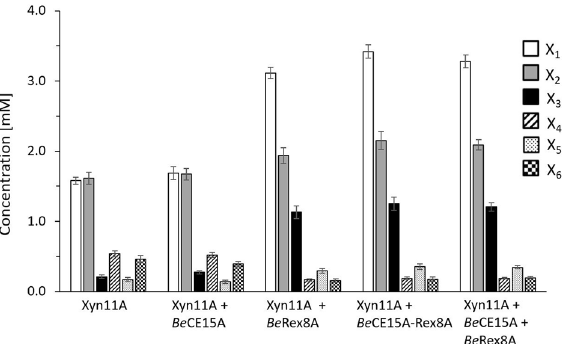
Figure 6. Xylooligosaccharide production profiles from corn cob biomass hydrolysis. The endo - β -1,4-xylanase Xyn11A from Neocallimastix patriciarum was either incubated alone or supplemented with Be CE15A, Be Rex8A, Be CE15A-Rex8A or an equimolar mix of Be CE15A and Be Rex8A. Reactions in which Be CE15A, Be Rex8A, and Be CE15A-Rex8A were incubated without Xyn11A yielded no detected sugars (data not shown), as expected of a Rex enzyme and a GE. Presented are xylose (X 1 , white), xylobiose (X 2 , gray), xylotriose (X 3 , black), xylotetraose (X 4 , striped), xylopentaose (X 5 , dotted), and xylohexaose (X 6 , checkered) concentrations after 30 h of incubation that were determined using high-performance anion-exchange chromatography with pulsed amperometric detection (HPAEC-PAD). Data are shown as average of triplicate experiments with standard errors of the